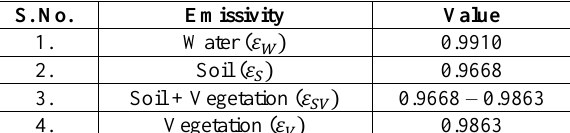
Table 5: Emissivity